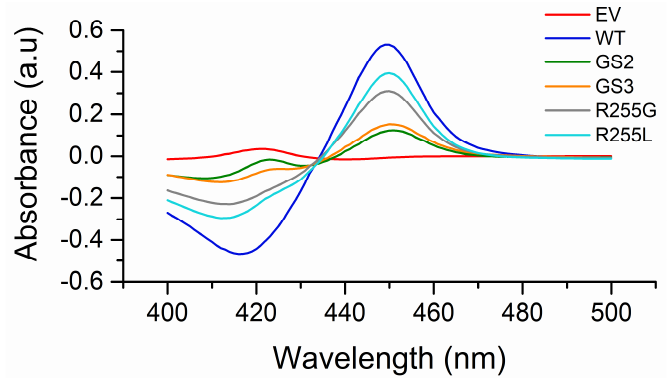
Figure A9. Absorption spectra for the produced variants of P450 BM3 in their ferrous carbon monoxide complex. A typical absorption spectrum for the WT of P450 BM3 is shown in blue. EV – empty vector (negative control), WT – wild-type, GS2 (R255S/P329H/F331L), and GS3 (I122V/ R255S/P329H/F331L).